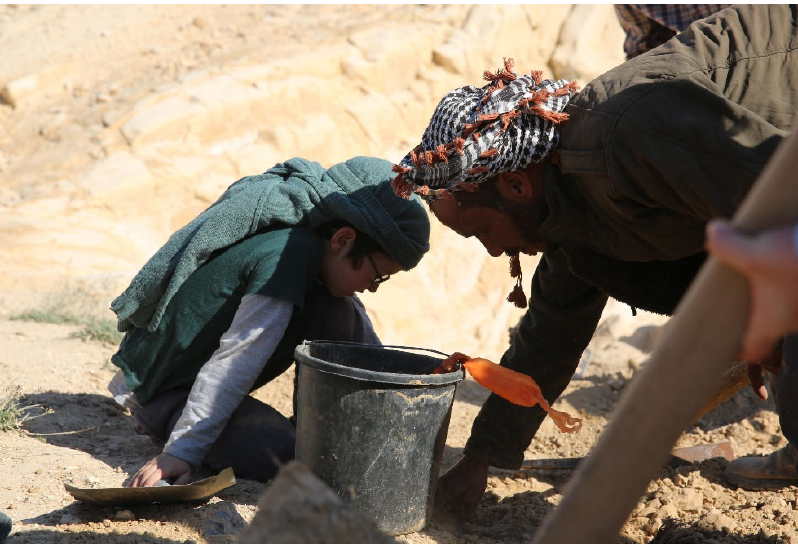
Figure 3. A symbolic image that signifies the concept of Environmental Reconciliation , coined by Common Views art collective to express their artistic vision. Displayed in the first intervention Common Views: Sourcing Water in Al Baqi’a valley 2020, are a Bedouin adult with a Jewish child working together to dig a water channel for the restoration of the Bir Umm al Atin water cistern. Photographed by Dan Farberoff. Image courtesy of the artist.